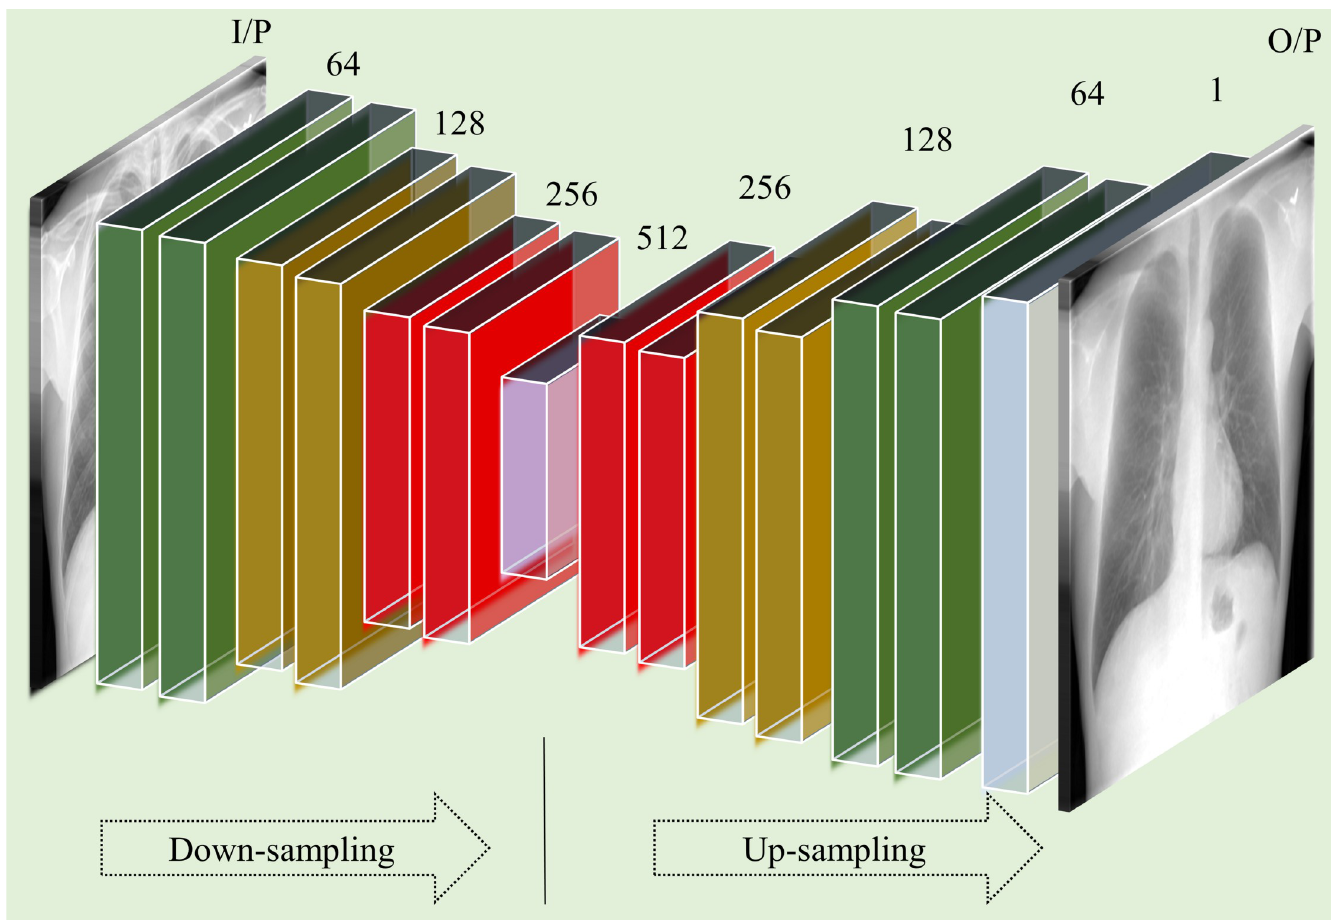
Fig 2. The architecture of the Autoencoder-BS model. The input to the model is a grayscale CXR image. The model has a symmetrical separable convolutional encoder and decoder architecture. https://doi.org/10.1371/journal.pone.0265691.g002 normalization process, and (ii) activations are not used outside the residual blocks and in the final layer. The network consists of 16 residual blocks with an identical layout. We used zero paddings to preserve the spatial dimensions of the input image. The residuals after the deepest